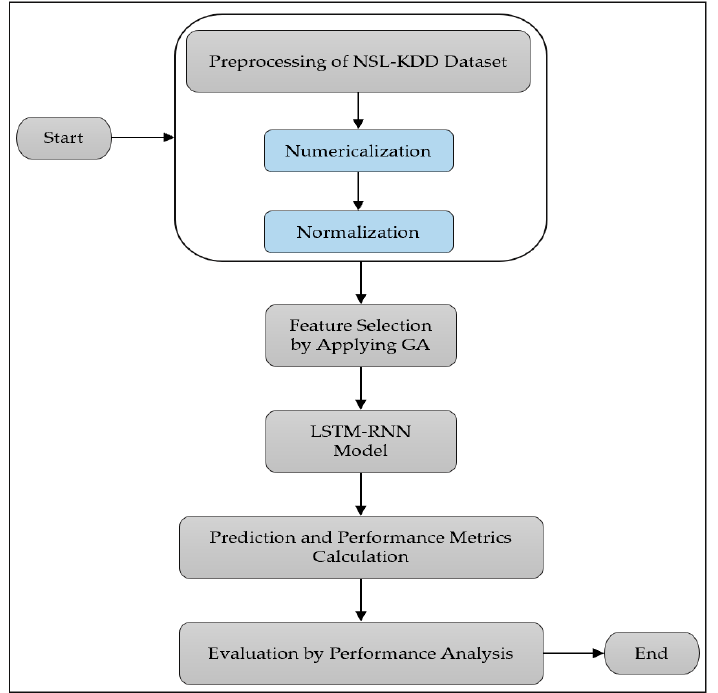
Figure 3. Flow-chart of the LSTM-RNN classifier with GA.